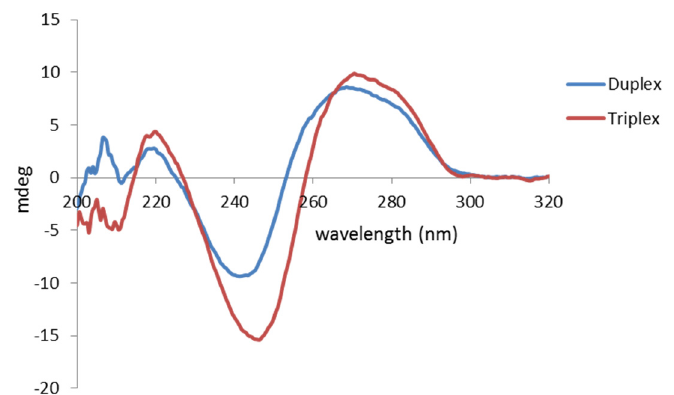
Figure A3. CD spectra of duplex (Compl + ss-DNA mtLSU target) and antiparallel triplex (PPRH + ss-DNA mtLSU target).